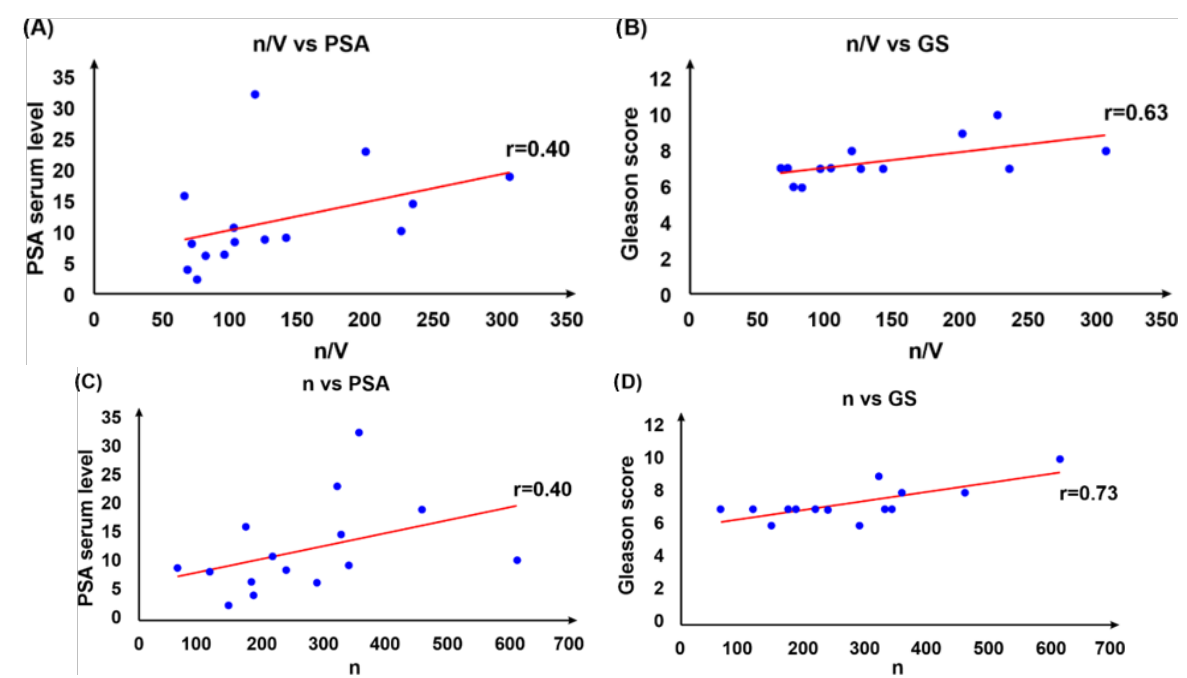
Figure 4. Correlations between n/V vs. PSA ( A ) and n/V vs. GS ( B ); n vs. PSA ( C ) and n vs. GS ( D ). A relatively weak correlation was identified for n/V vs. PSA with r value at r = 0.40, and for n vs. PSA with r value at r = 0.42. At the same time, moderate correlation was identified for n/V vs. GS with r value at r = 0.63, and for n vs. GS with r value at r = 0.73.